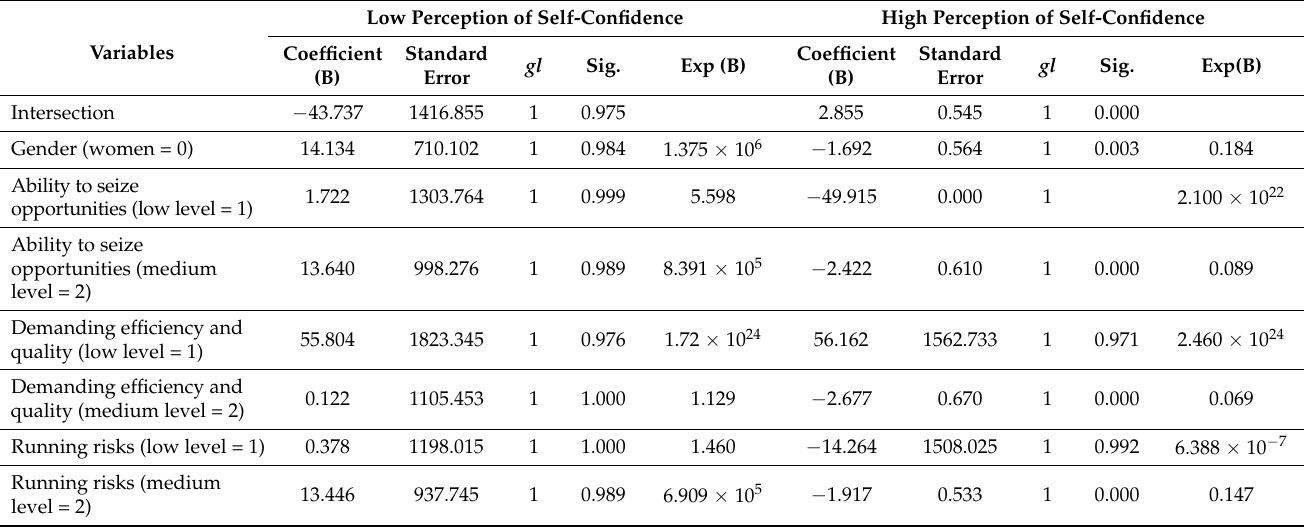
Table 3. Regression coefficients for a multinomial logistic